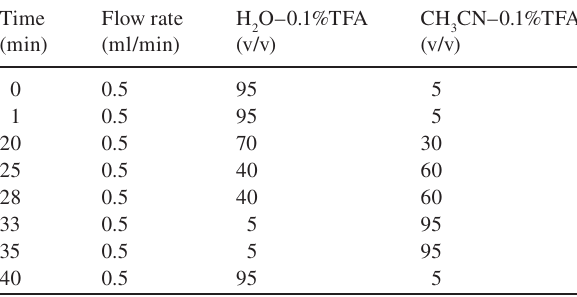
25 µ l and/or 50 µ l of the supernatant were injected into